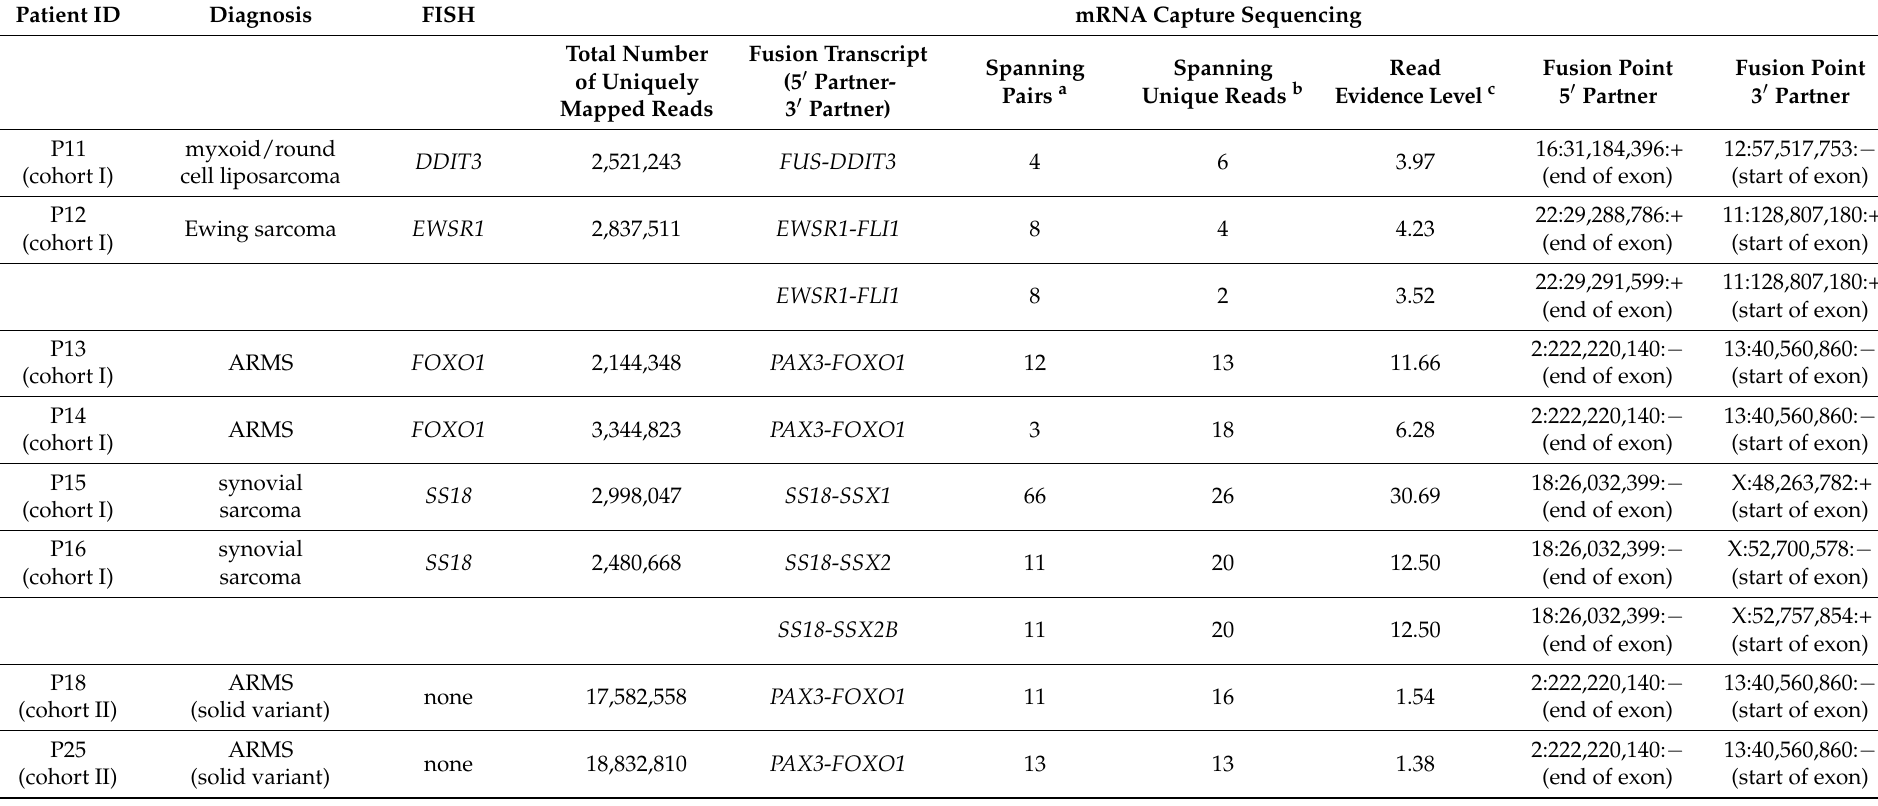
Table 1. mRNA capture sequencing enhances the detection of pathognomonic fusions in sarcoma. For each patient in cohort I (patient ID P11-P16) and II (patient ID P18-P29) with a pathognomonic fusion, the patient’s diagnosis is indicated, as well as the detected rearrangement by fluorescence in situ hybridization (FISH, only for patients of cohort I), and the TruSight RNA Pan-Cancer Panel (cohort I) or TruSeq RNA Exome sequencing (cohort II) results. Two different pathognomonic fusion transcripts were detected for patient P12 (same fusion transcript partners, but different chromosomal position of the 5’ end of the fusion junction) and P16 (different 3 (cid:48) fusion transcript